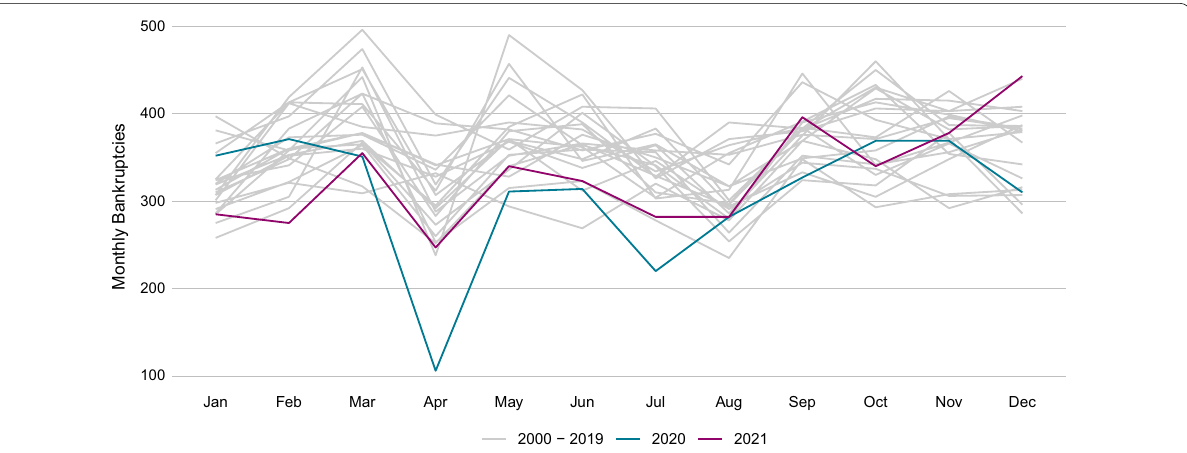
Fig. 1 Seasonal pattern of firm bankruptcies in Switzerland. Notes : The figure shows the monthly seasonal pattern of total firm bankrupcties in Switzerland excluding SCO Art. 731b